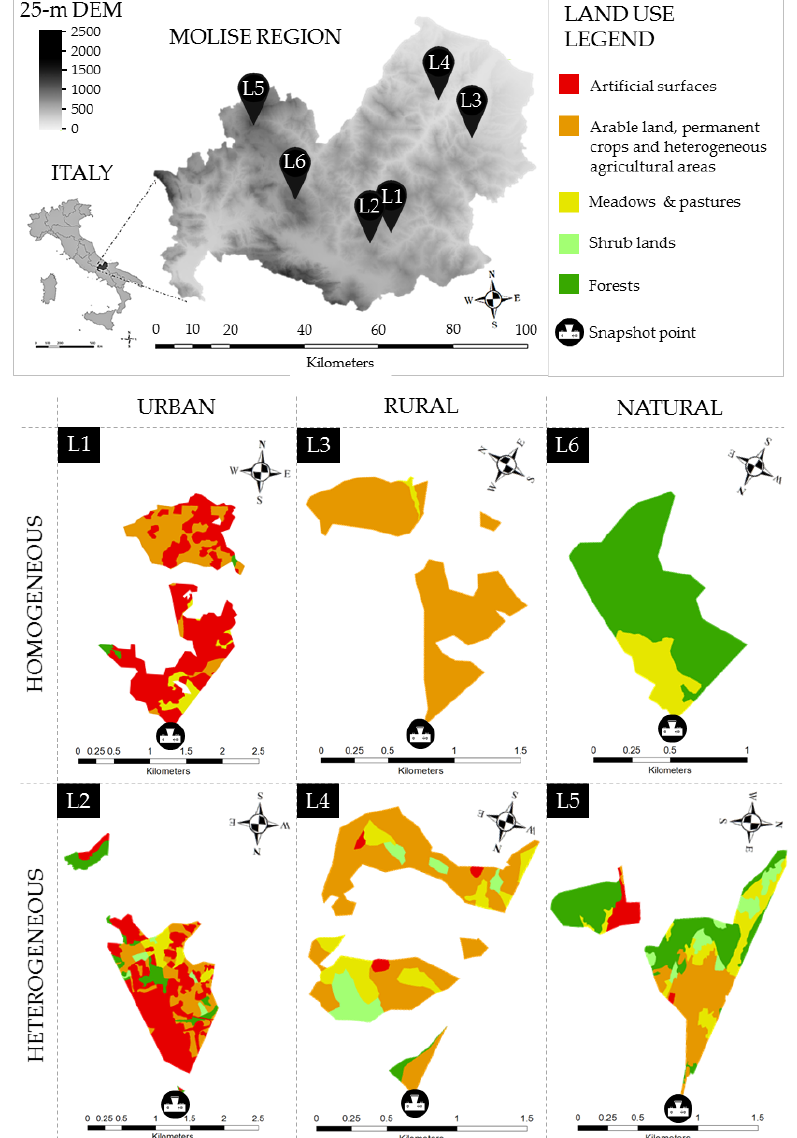
Figure 1. The six selected viewsheds representative of the urban – rural – natural landscape gradient and their geographical location in the study area.